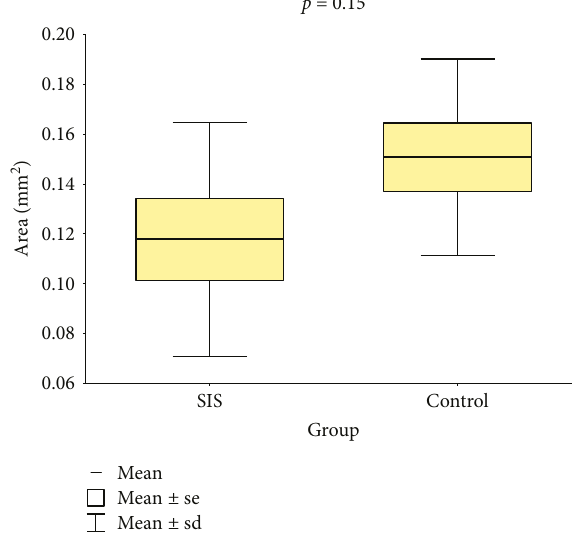
Figure 8: Tracheal defect areas of the